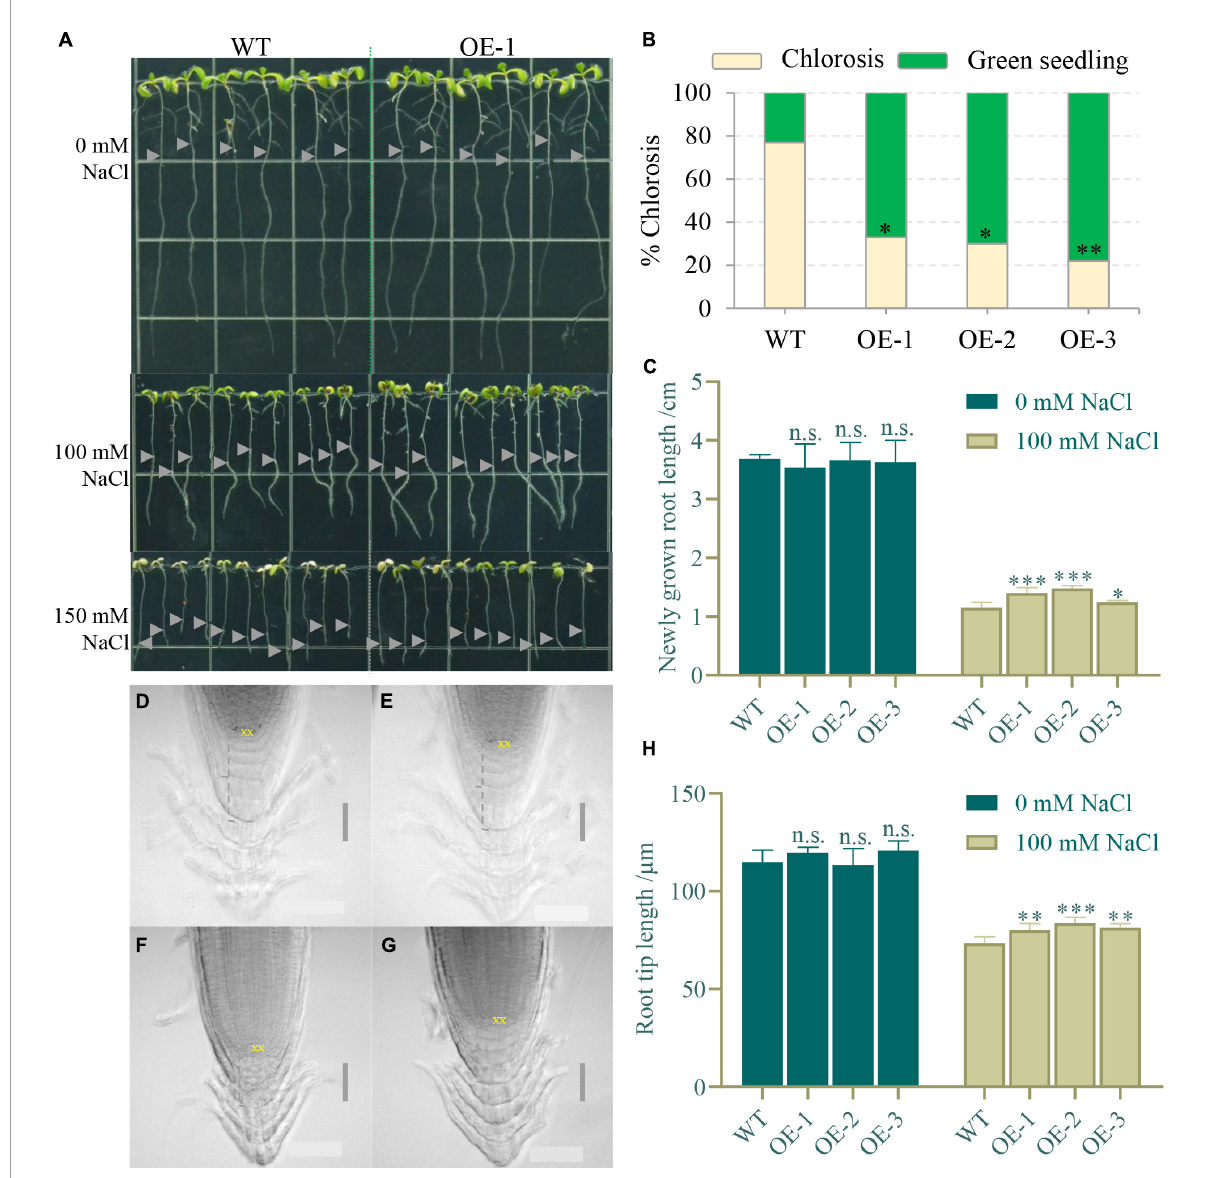
FIGURE5 NbCIPK25 overexpression maintains root development under salt stress. (A) The 5-day-old WT and NtCIPK25 overexpressing plants (OE-1, OE-2, and OE-3 representing three individual lines) grew on a medium containing 0 mM NaCl, 100 mM NaCl, and 150 mM NaCl for 3 days; gray triangles indicate starting points of root tips on the respective medium per treatment. Square length: 1 cm. (B) Percentage of chlorosis for WT and transgenic seedlings treated with 150 mM NaCl for 3 days. (C) Newly grown length of the primary root. (D–G) Micrographs showing the primary root tip of WT (D) and transgenic seedlings (E) treated with 0 mM NaCl for 3 days; and the primary root tip of WT (F) and transgenic seedling (G) treated with 100 mM NaCl for 3 days; scale bar: 50 µ m. “XX” indicates the quiescent center (QC). (H) The root tip length is measured along the dashed line indicated in D–G . (B,C,H) Data represent means ± SD, three biological replicates, and a t-test was used to determine statistical significance, “ ∗ ” p < 0.05, “ ∗∗ ” p < 0.01, “ ∗∗∗ ” p < 0.001, n.s.: not